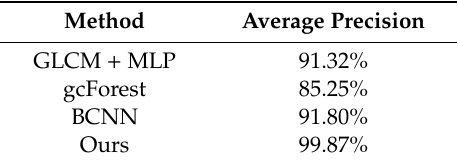
Table 3. Comparison of results on the diode glass bulb surface defect dataset.